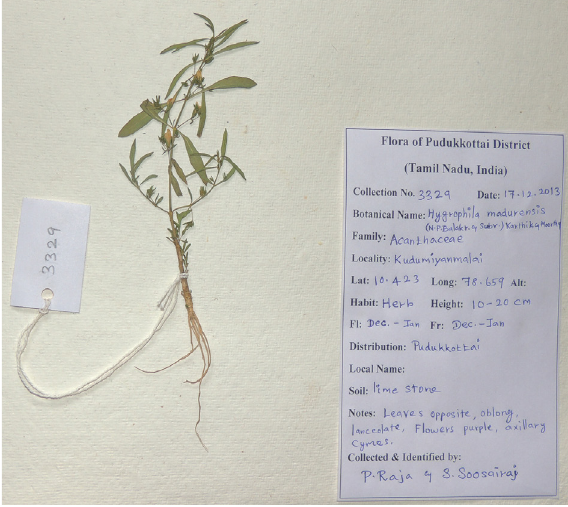
Image 3. Herbarium image of Hygrophila